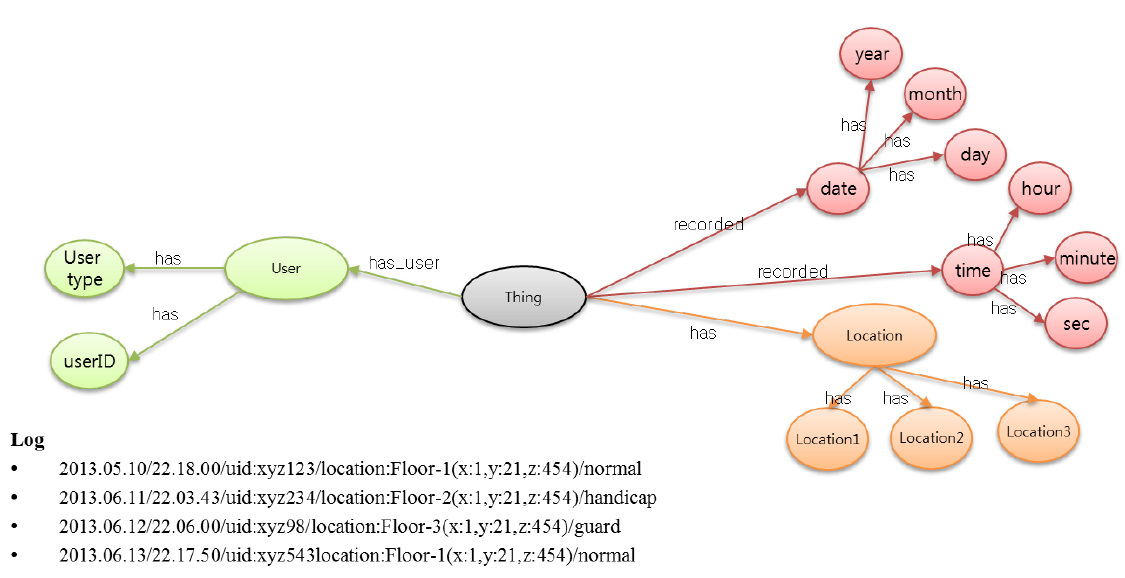
Figure 12. Emergency log is collected from ViOs. All the fire emergency related objects are connected with each other in the semantic ontology